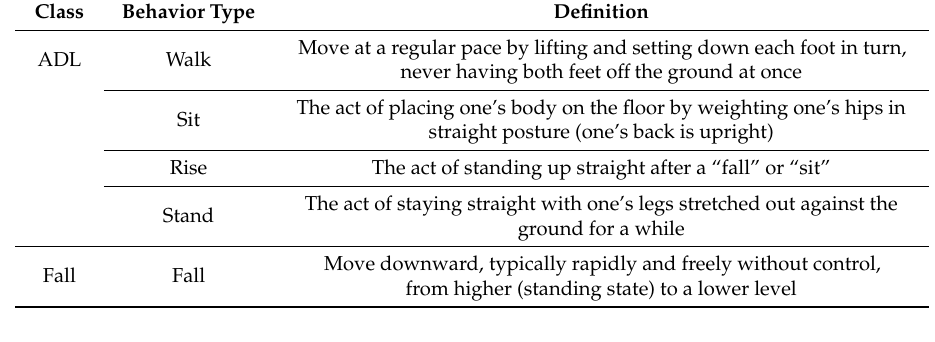
Table 2. Class classification and detailed definition for each type of behavior.